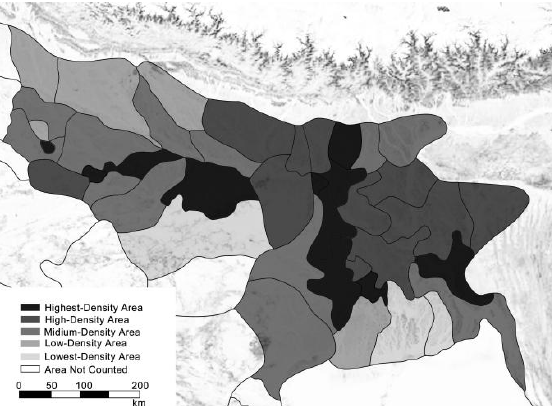
Figure 10. Density of places in the middle and lower Ganges Valley in 1794. Source: the authors; Base Map: Google satellite map; Reference: [65].